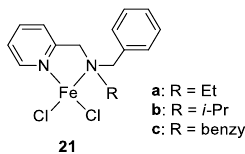
Figure 13. Amine – pyridine iron complexes with di-substituted amine donors.